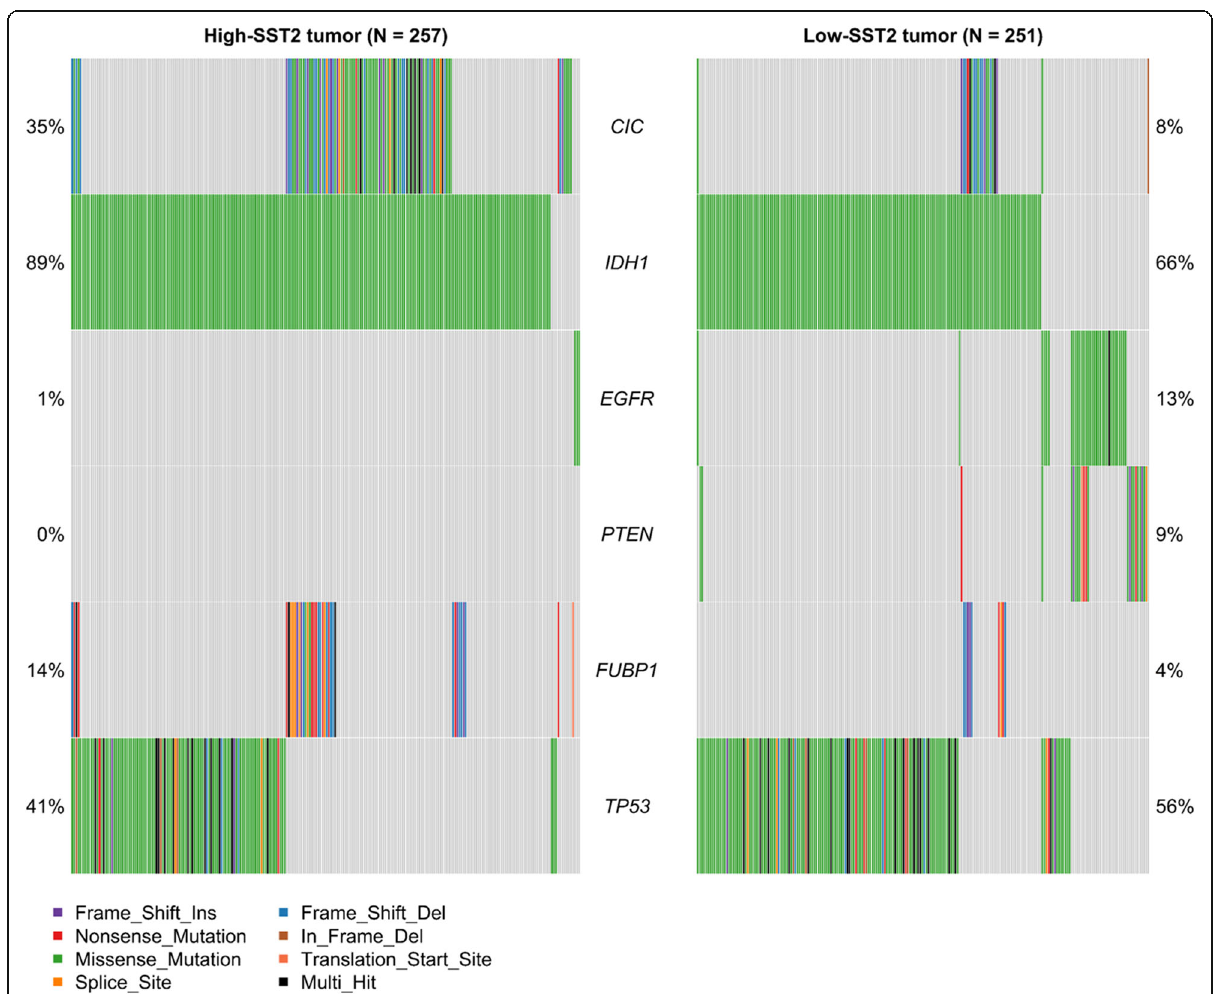
Fig. 3 Gene mutational profiles in the high-SST2 LGG and low-SST2 LGG. Six genes showed genetic alteration in accordance with SST2 status. IDH, CIC, and FUBP1 mutations were more in high-SST2 tumor. On the contrary, EGFR, PTEN, and TP53 mutations were more in low-SST2